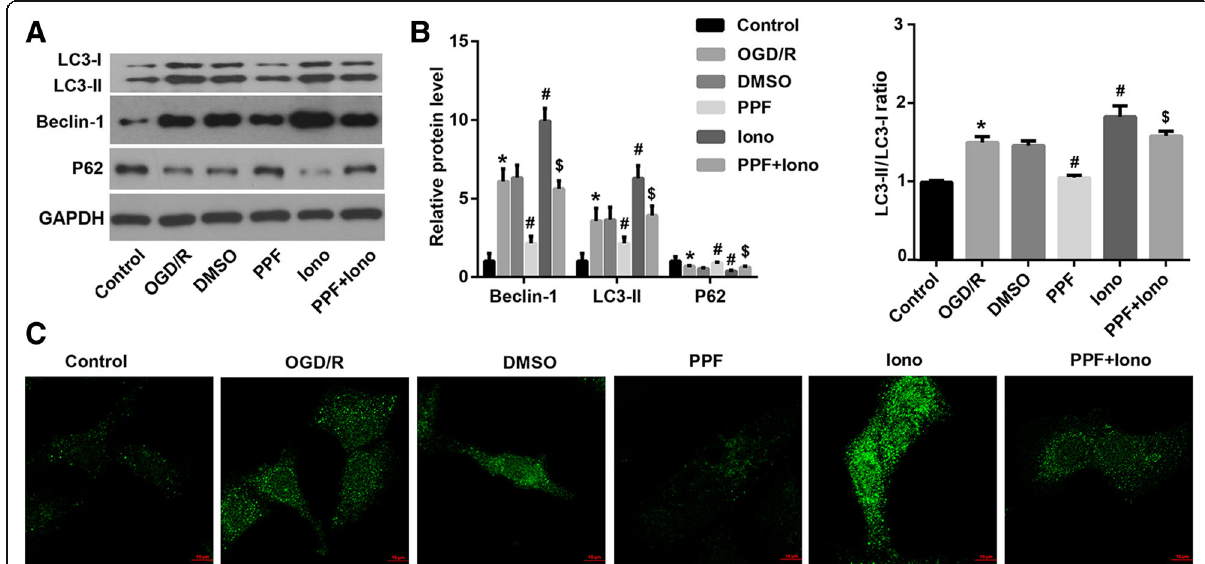
Fig. 5 [Ca 2+ ]i elevation abolished the PPF-mediated suppression of autophagy in OGD/R-exposed neurons. OGD/R-exposed neurons were pre- treated with a Ca 2+ ionophore ionomycin (iono, 0.3 μ M), followed by propofol (PPF, 30 μ M in 0.1% DMSO) treatment. a , b Western blot was performed to evaluate the effects of [Ca 2+ ]i elevator ionomycin on protein expression of autophagy-related genes LC3, Beclin1, and p62. Quantification of western blots was shown. c The autophagosome puncta of GFP-LC3 by immunofluorescence. Scale bar: 10 μ m. Values are represented as the mean±SD from three independent experiments. * p <0.05 vs. Control group; # p <0.05 vs. DMSO group; $ p <0.05 vs. PPF